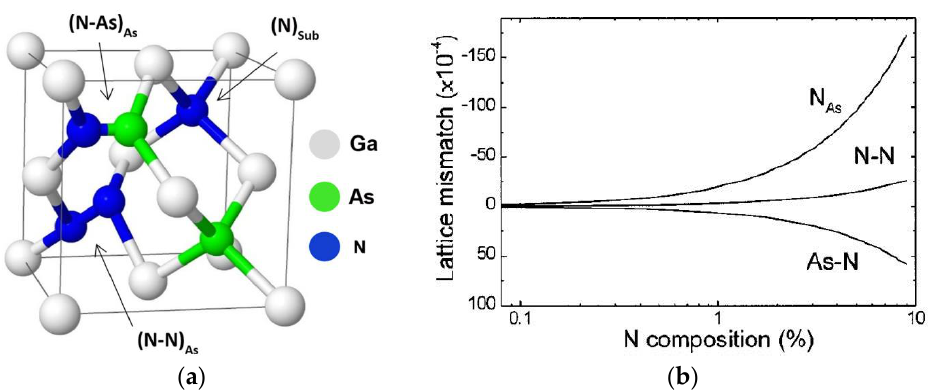
Figure 2. Nitrogen related defects in GaAsN: ( a ) split interstitial N complexes (N-As) As and (N-N) As [18]; ( b ) lattice mismatches between GaAsN and GaAs caused by substitutional nitrogen N As , complexes (N-N) As and (N-As) As for different N content [17]. Reprinted with permission from [17,18]. Copyright 2015, 2001, AIP Publishing.